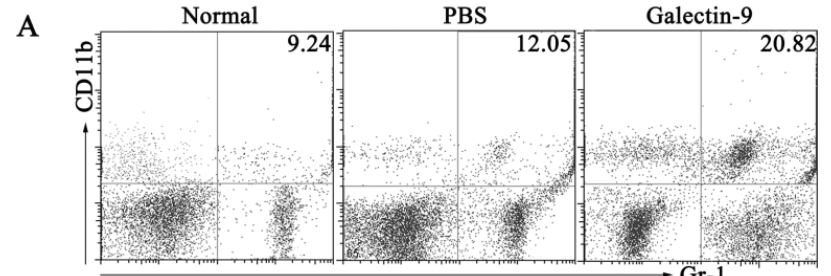
Figure 3. Effects of galectin-9 administration on CD11b + Gr-1 + myeloid suppressor cells. BALB/c male mice were infected with CVB3 on day 0 and received recombinant galectin-9 (100 μg/mL, n = 8) or PBS ( n = 8) IP daily from day 3 to day 7. ( A ) Then the splenocytes were isolated on day 7 after enzymatic digestion and analyzed for CD11b + Gr-1 + myeloid suppressor cells by FACS; and ( B – D ) Phenotypic characterization of CD11b + Gr-1 + myeloid suppressor cells from galectin-9-treated animals with respect to the expression of Ly6G, Ly6C, CD86, F4/80, PDCA-1 and Tim-3 is shown; Data show the mean ± SEM. * , p < 0.05. Similar results were obtained in three separate experiments and the representative results are indicated in ( A ), ( B ) and ( D